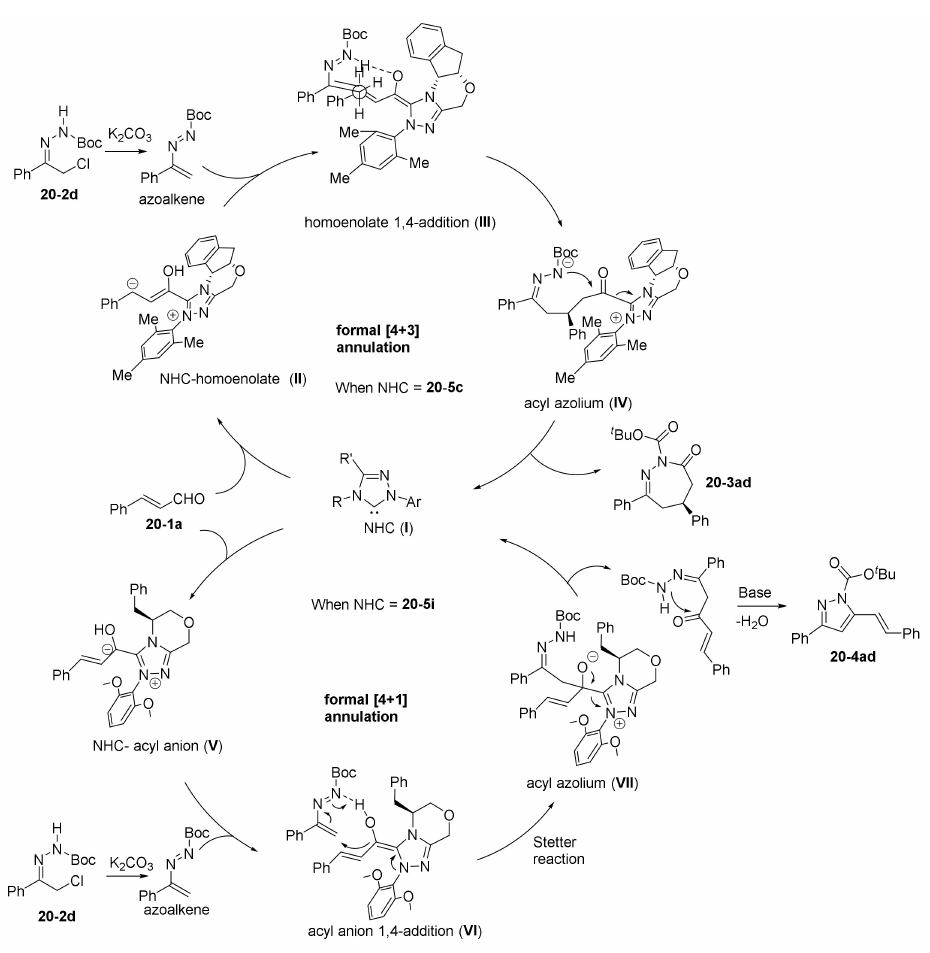
Glorius and co-workers also reported the NHC-catalyzed regiodivergent synthesis of pyridazino[6,1- a ]isoquinoline and pyrazolo[5,1- a ]isoquinolines by formal [3+3] and [3+2] annulations via a homoenolate intermediate and an enol intermediate,